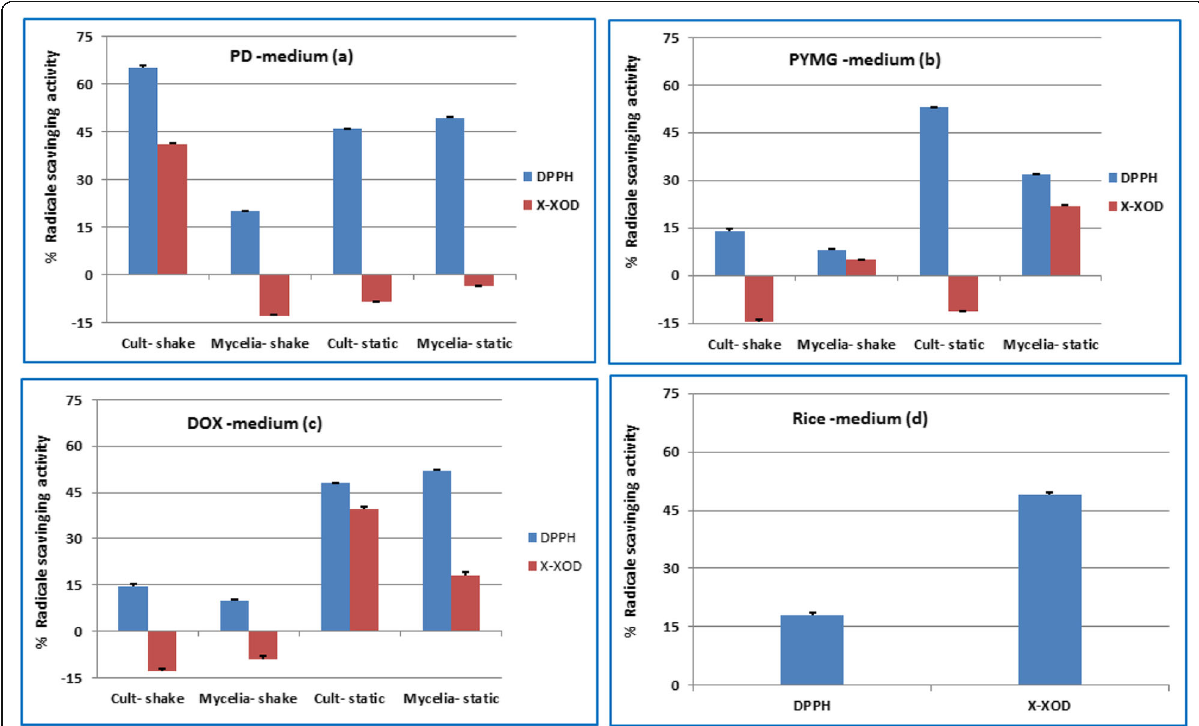
Fig. 3 Free radical scavenging activity of secondary metabolite extracts from culture and mycelia (static and shake) of different media in the DPPH radical and xanthine-XOD assays. Values are expressed as mean ± SD, n = 3, at a concentration of 200 μ g/ml for all tested